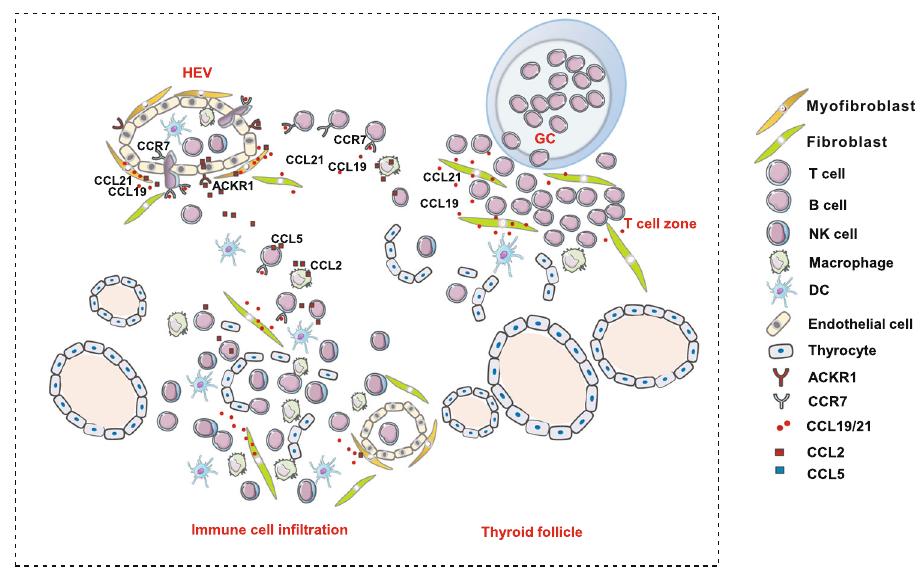
Fig. 9 Hypothesized model of the roles stromal cells play in immune in fi ltration in HT. In the thyroid tissues of HT patients, blood immune cells migrate through HEVs under the chemotaxis of CCL19 or CCL21 secreted by CCL21 + myo fi broblasts and CCL21 + fi broblasts distributed in the adventitia of HEVs and around HEVs, respectively. Meanwhile, ACKR1 + endothelial cells facilitate the migration by translocating CCL2 and CCL5 secreted by CCL21 + myo fi broblast/ fi broblasts and immune cells to the lumen of HEVs. Then these in fi ltrated immune cells are attracted to the sites with scattered CCL21 + fi broblasts. In some regions of the thyroid, where TLOs with germinal centers are generated, CCL21 + fi broblasts are distributed in T cell zones and may play a role in structure organization and T cell